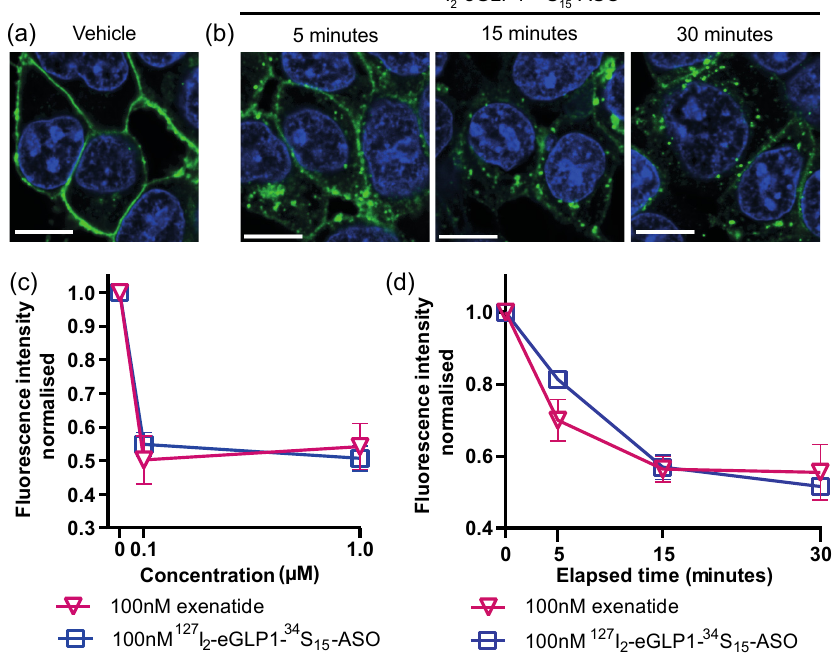
Figure 4. eGLP1-ASO-mediated GLP1R internalization in GLP1R-HEK293 cells. Representative confocal images of GLP1R localization in GLP1R-HEK293 cells following incubation with vehicle control ( a ) or 127 I 2 -eGLP1- 34 S 15 -ASO (100 nM) for the time points indicated ( b ). Nuclei were counter- stained with DAPI. ( c ) GLP1R mean fluorescence intensity was calculated from a region of interest encompassing the cell border. ( d ) GLP1R-HEK293 cells were incubated with 127 I 2 -eGLP1- 34 S 15 -ASO or exenatide for 5–30 min at indicated concentrations and image analysis performed as in ( b ). For each condition, cells from at least 10 fields of view were analyzed in duplicate wells and data were expressed as mean ± SEM. Scale bar = 10 μ m.